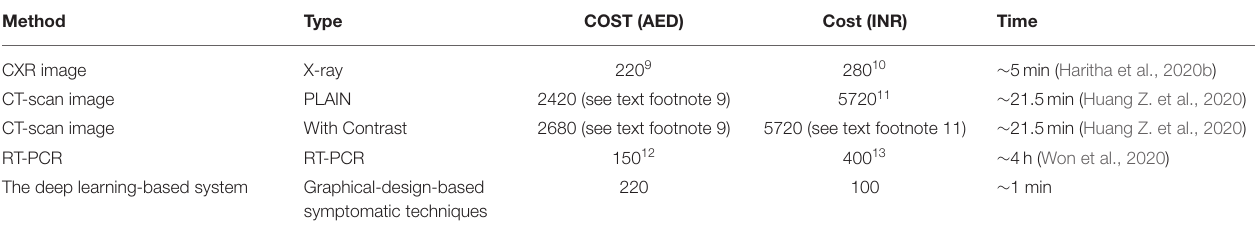
TABLE 5 | Comparison of detection type and time in AED and